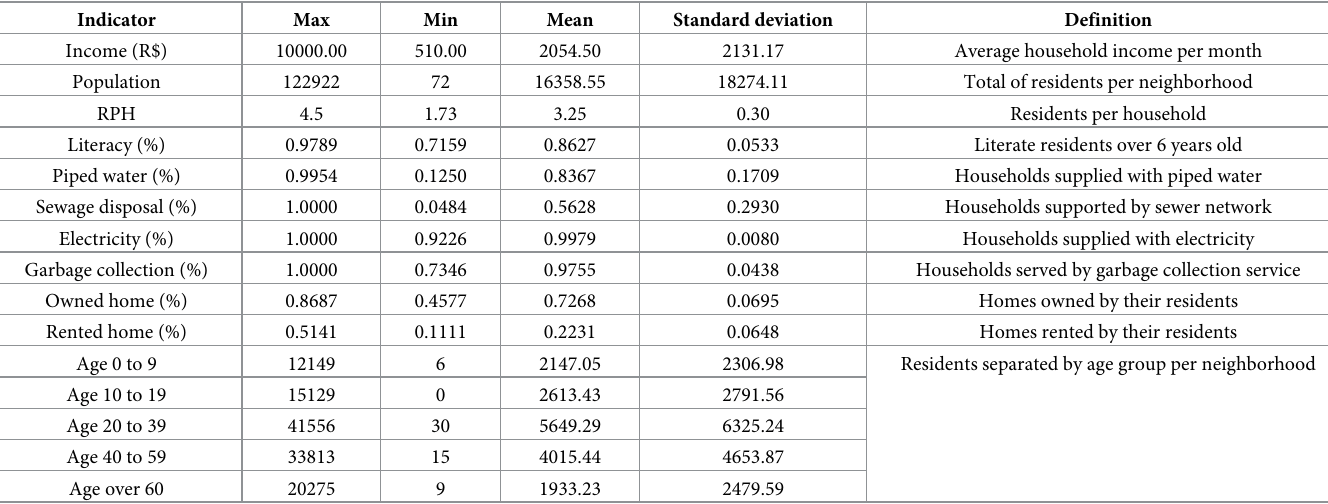
Table 1. Descriptive statistics of census